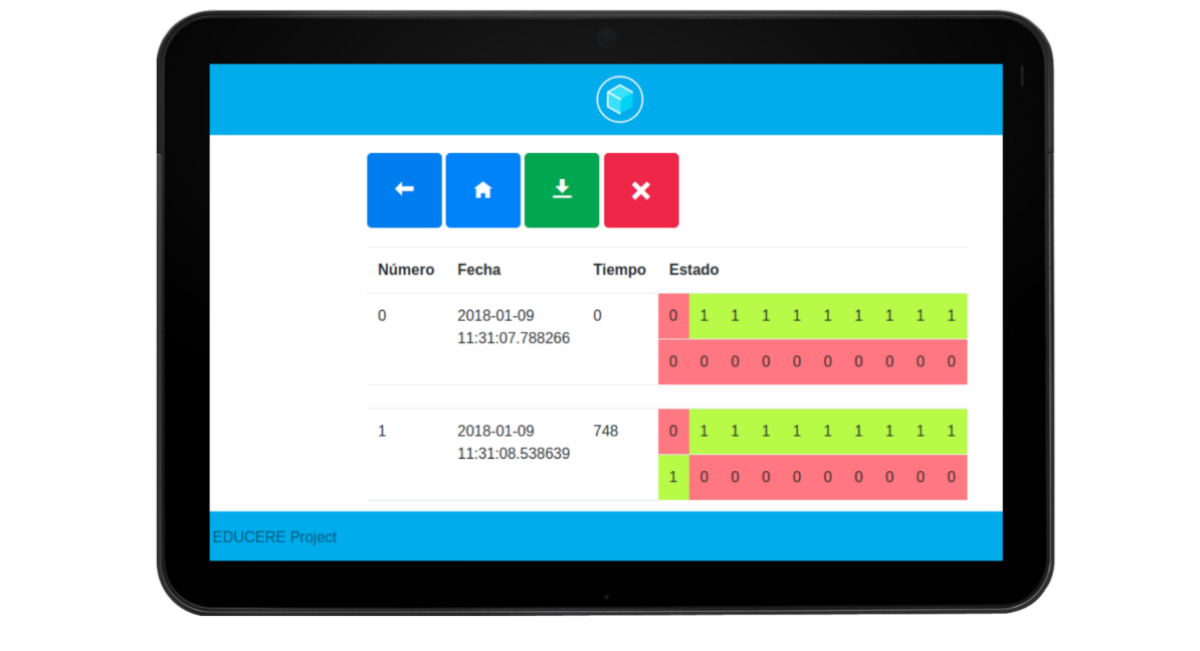
Figure 2. Example of results of a test as shown in the Web interface from a tablet.